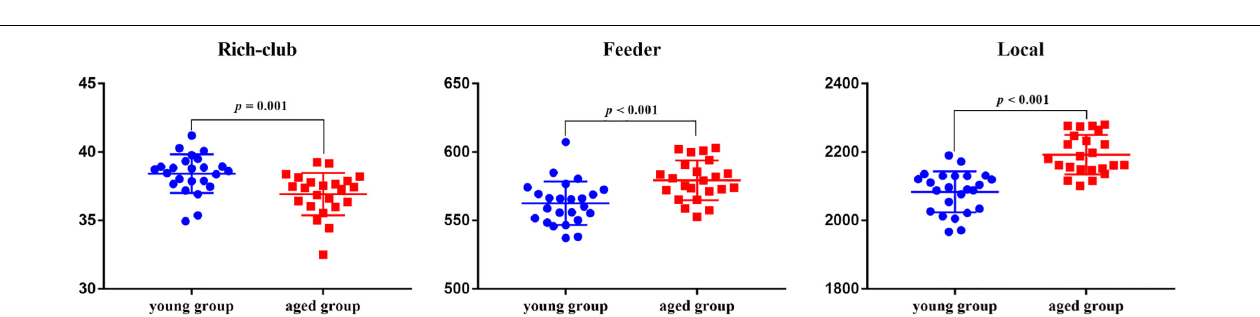
FIGURE 5 | Between-group differences of overall strength in rich-club, feeder, and local connections.